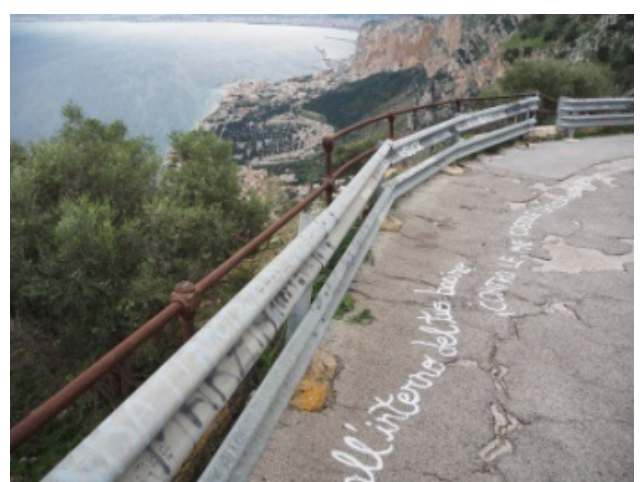
Figg. 7, 8 : Milan, 20 December